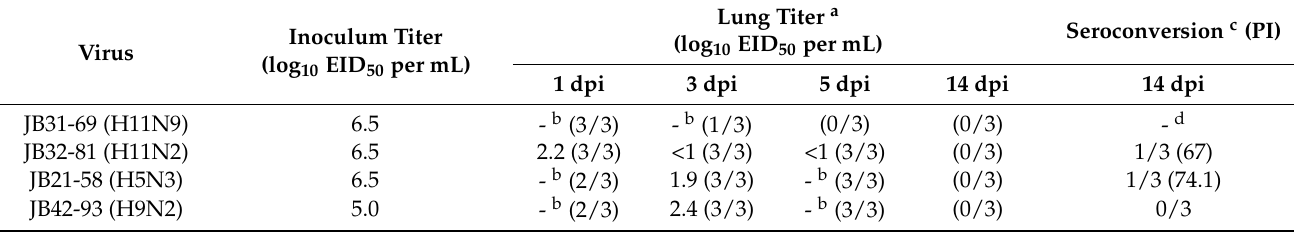
a The viral titers (log 10 EID 50 / mL) of the pooled samples with numbers of animals in which the virus was detected by qRT-PCR per number inoculated shown in parentheses. b Virus not recovered. c Numbers of animals in which positive serum was detected per number inoculated, with percent inhibition (PI) values shown in parentheses. d Data was not shown. PI value = [1 − (OD test sample/OD negative control)] × 100 (positive PI value > 50). The ELISA kit is based on a competitive ELISA method and OD negative control become larger than OD positive